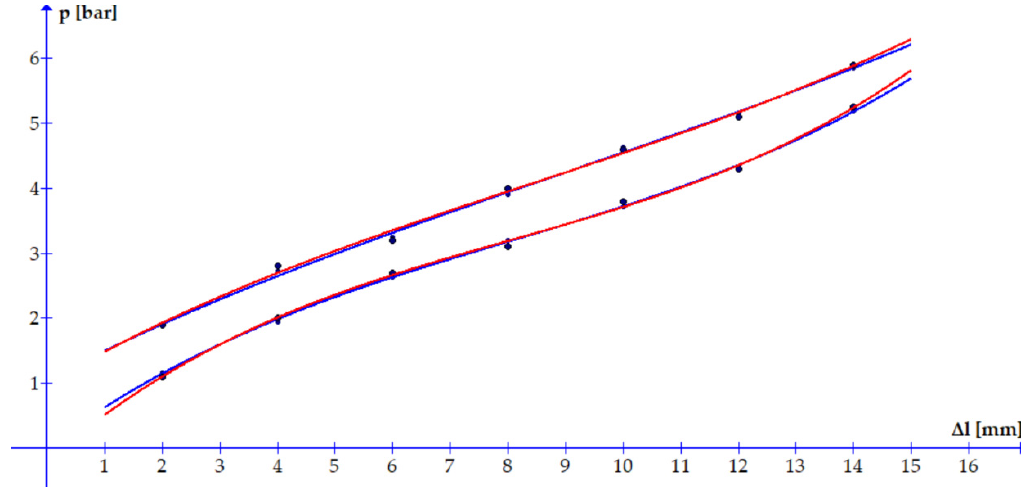
Figure 15. The motion curve of an object with a mass of 2.55 kg. A significant disadvantage of the pneumatic muscles used for precise positioning systems is that, for each actuator, experiments must be performed, then it is necessary to determine the dependencies ( p = f ( ∆ l )) in both the inflation and the deflation phase. These relationships must then be loaded into the